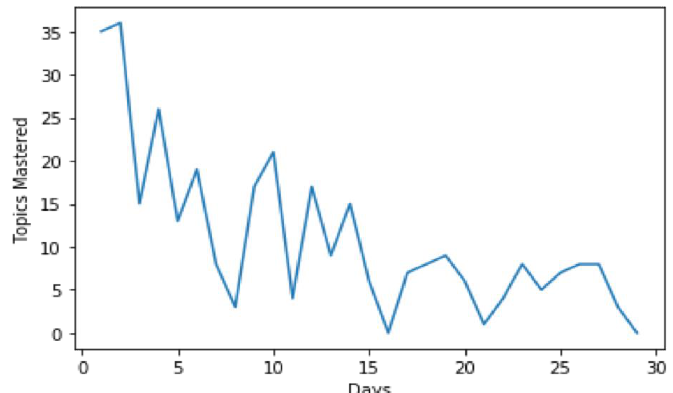
Figure 4. The Graph of Student Learning expressed as topic mastered over time